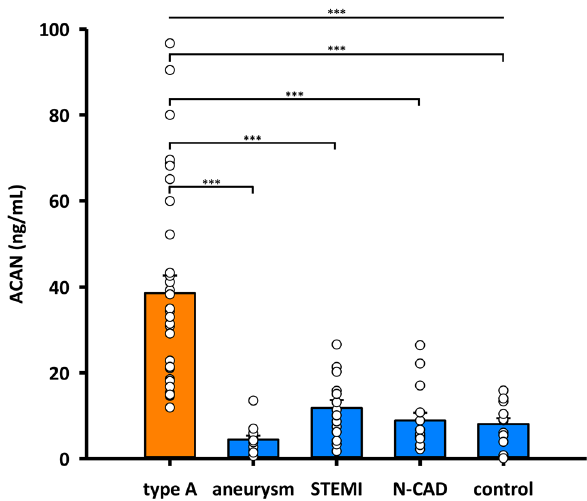
Figure 4. ACAN levels are not enhanced in plasma samples of patients without ATAAD. ACAN concentration in plasma of patients with ATAAD (type A, n = 33), asymptomatic chronic aneurysm of the ascending aorta (aneurysm, n = 13), MI with an acute ST-elevation (STEMI, n = 18), without known coronary artery disease (N-CAD, n = 15) and healthy volunteers (control, n = 12). Values represent means ± SEM. *** p < 0.001. Significance of difference was tested with Wilcoxon-Mann–Whitney